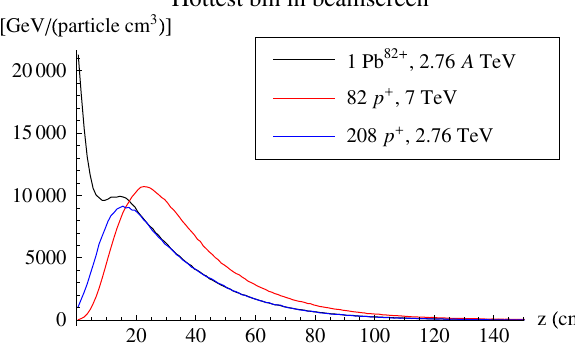
FIG. 19. (Color) The energy deposition for the 208 Pb 82 þ ions and protons at LHC energy in the beam screen, as a function of the longitudinal coordinate in the magnet, averaged over 0 : 1 (cid:3) 0 : 1 mm 2 transversally and 10 mm longitudinally.